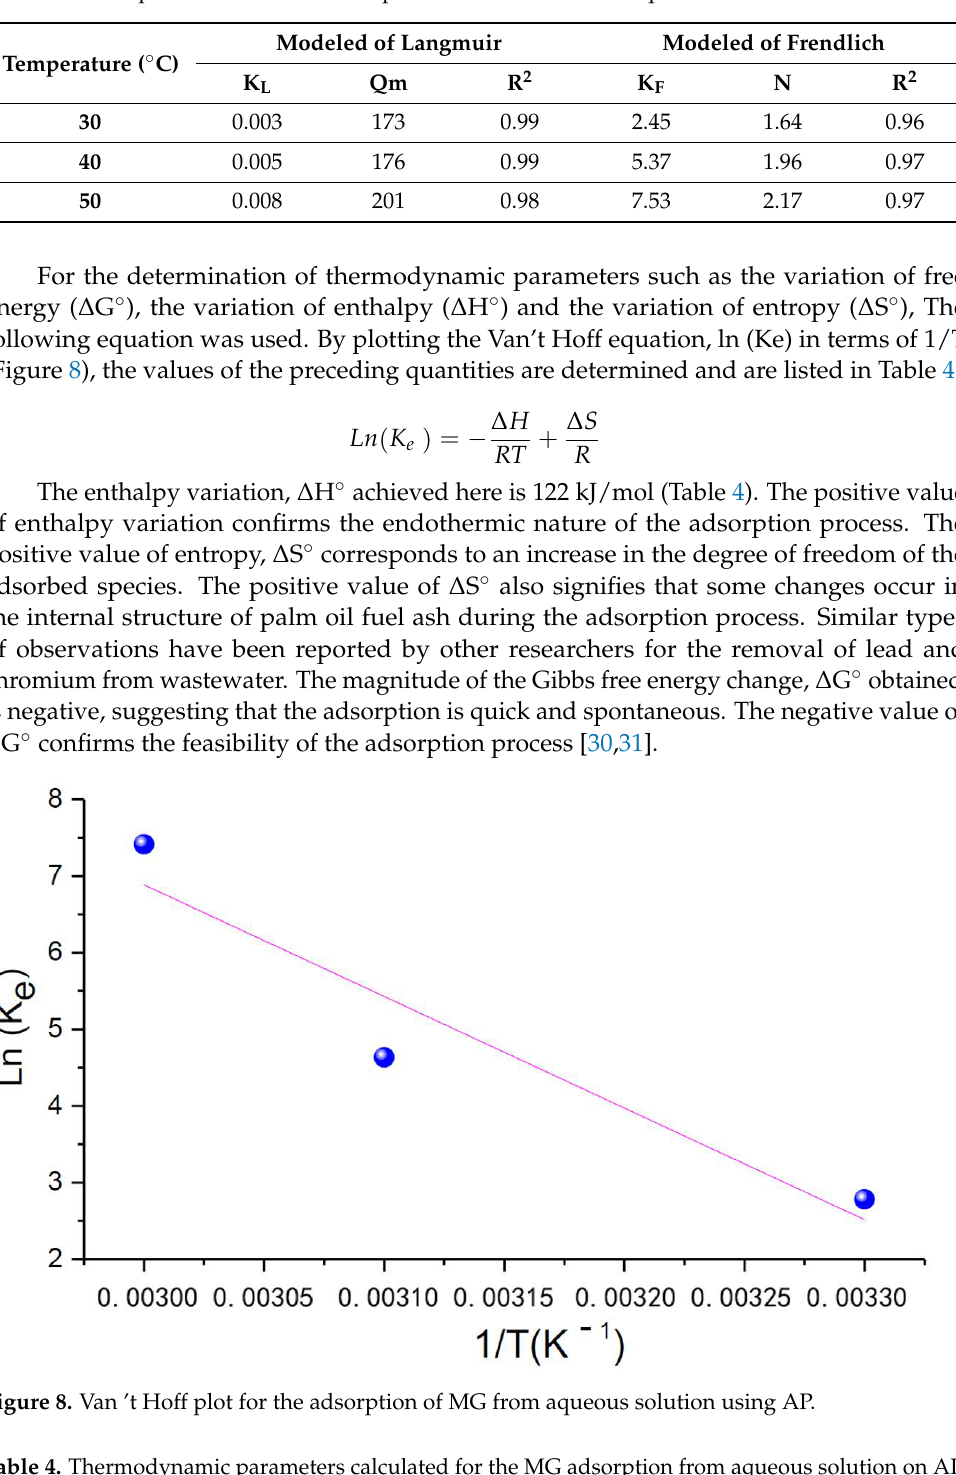
Table 3. Model parameters for the adsorption of MG on AP from aqueous solution.